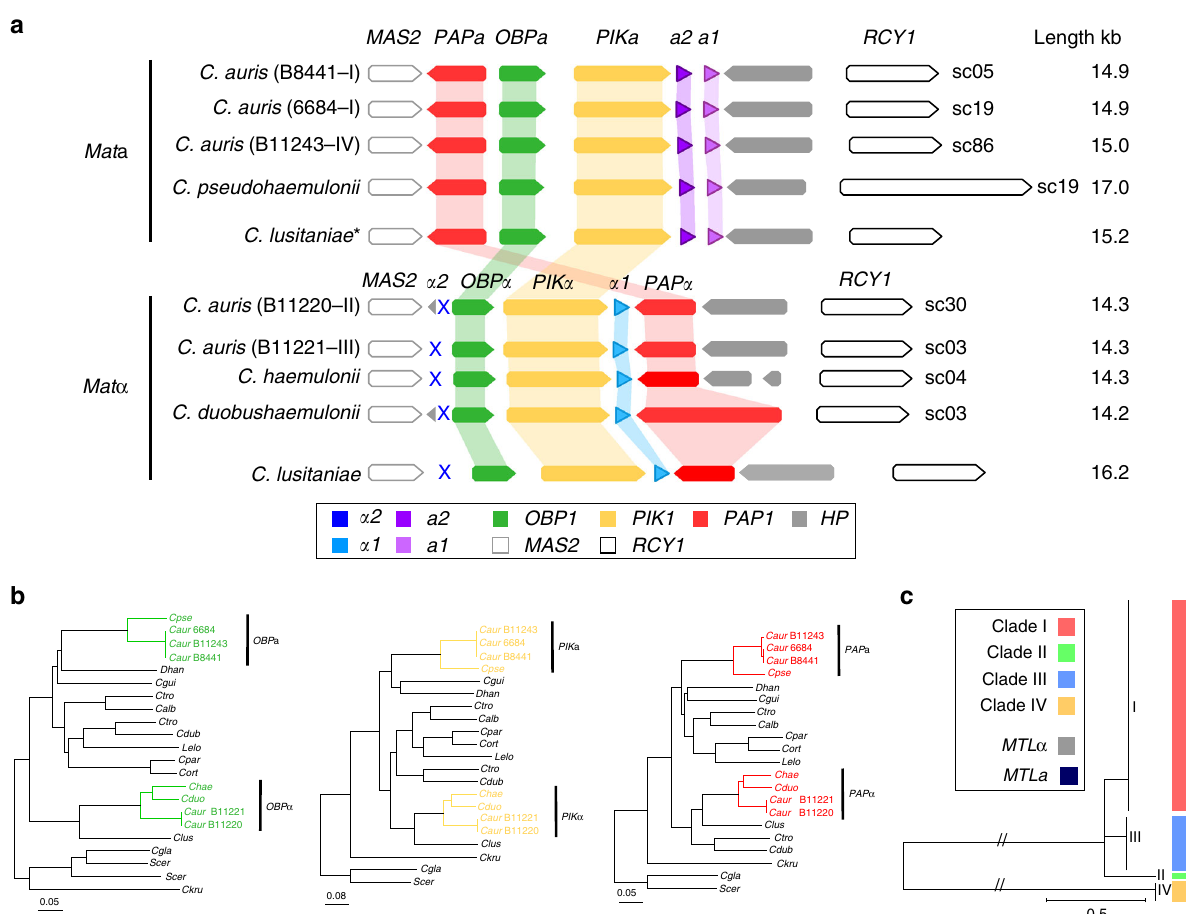
Fig. 2 Mating-type loci ( MTL ) in Candida auris and closely related species. a Synteny schema depicting the orientation and conservation of the color-coded MTL idiomorphs and genes adjacent to the MTL . The putative MTL in C. auris , C. haemulonii , C. duobushaemulonii , and C. pseudohaemulonii are shown in comparison with the MTL a and MTL α idiomorphs from C. lusitaniae . b Phylogenetic analysis of the non-mating fl anking genes ( PIK1/OBP1/PAP1 )